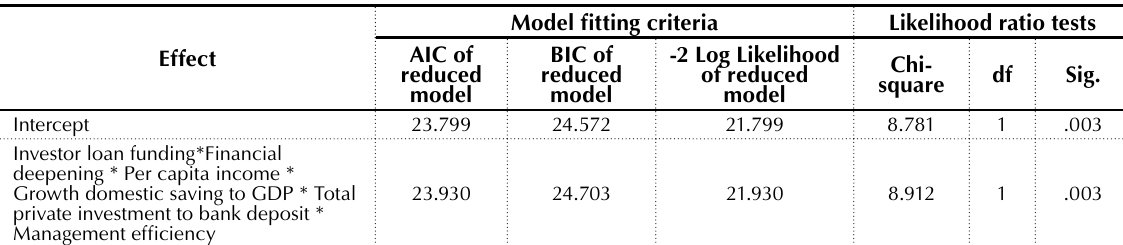
Table 26. Likelihood ratio tests of profitability and sustainability of